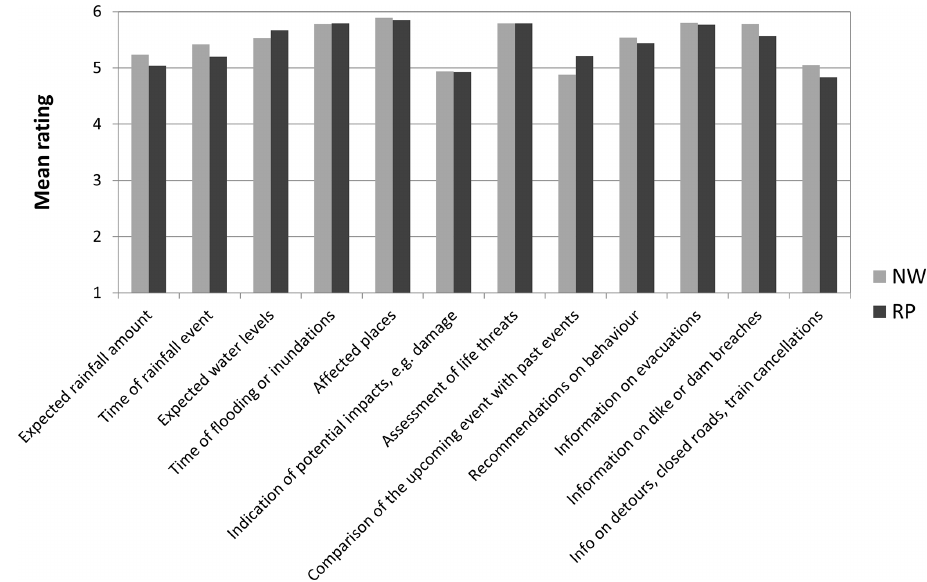
Figure 6. Mean rating of surveyed respondents with regard to the importance of different pieces of warning information or content (NW: n = 837 to 882; RP: n = 404 to 418; rating scale from 1 “This piece of information is not important at all” to 6 “This piece of information is very important”).